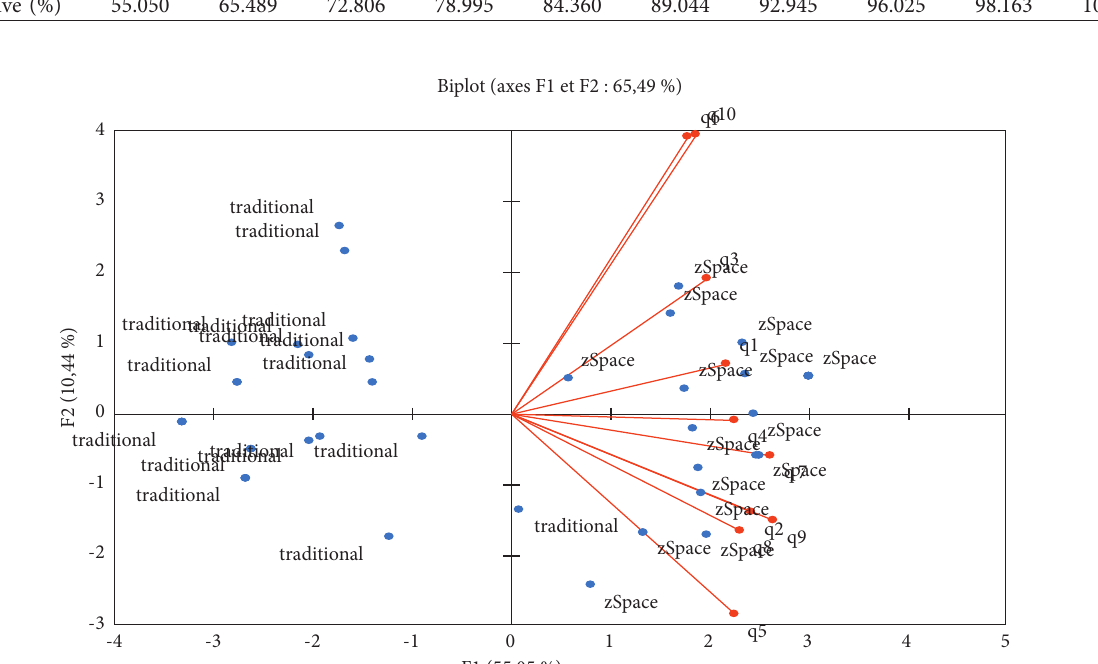
Figure 5: Common representation of the variables and the observations (the correlation between variables and its relationship with